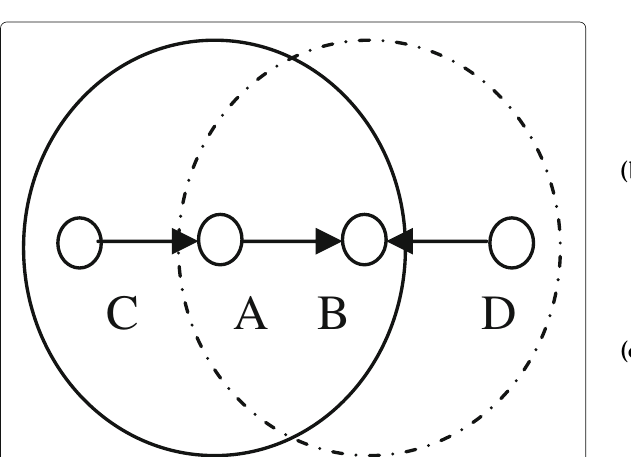
Fig. 3 Hidden terminal problem in contention-based